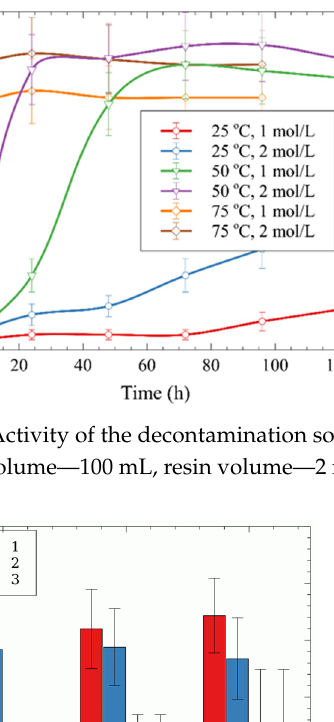
Figure 4. Activity of the decontamination solution depending on the concentration of H 2 SO 4 , temperature, and contact time: ( a ) 24 h, ( b ) 48 h.